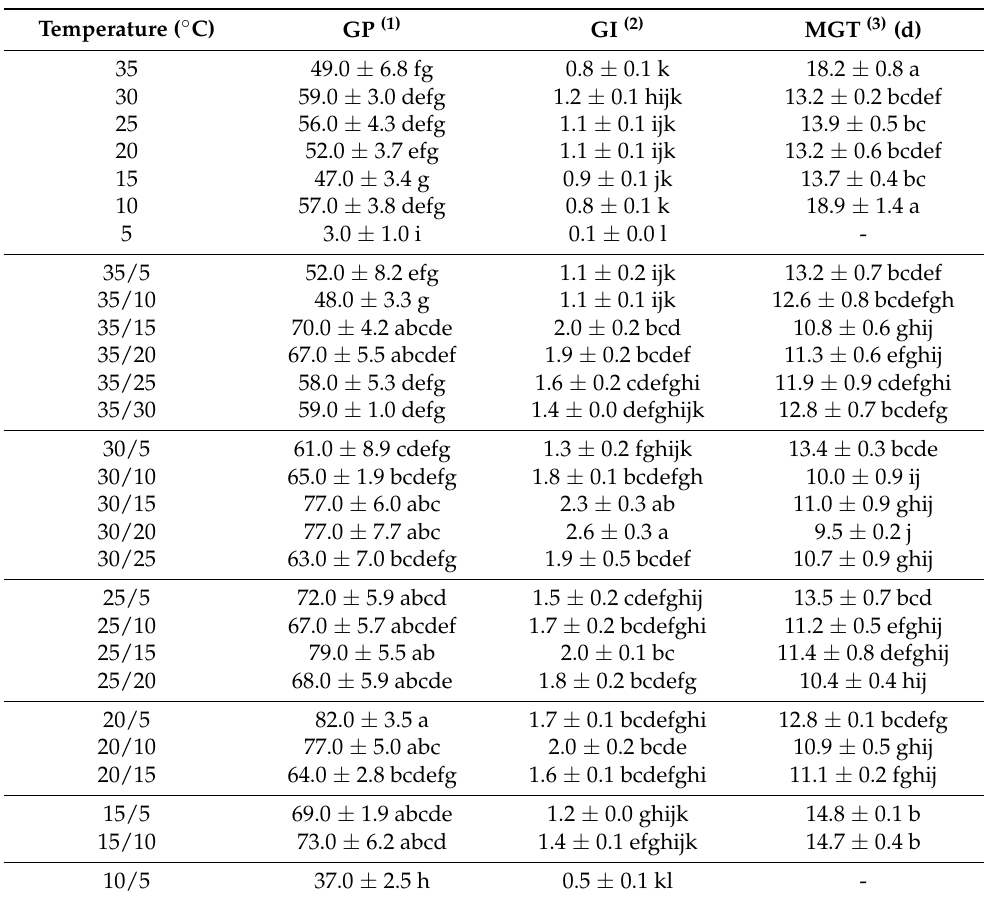
Table 4. Germination (mean ± standard error) of F. rhynchophylla seeds at different temperatures after 4 weeks cold